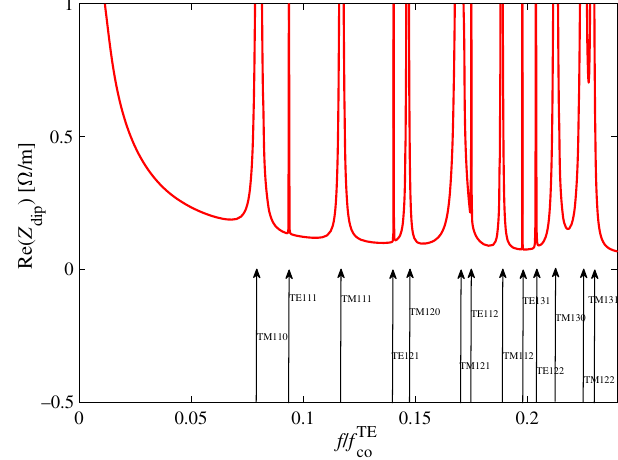
FIG. 4. TM and TE modes excited in the dipolar impedance. Frequency is normalized over the first beam pipe propagating mode (TE 11 ). Mode matching parameters: b ¼ 1 cm, t ¼ 25 cm,